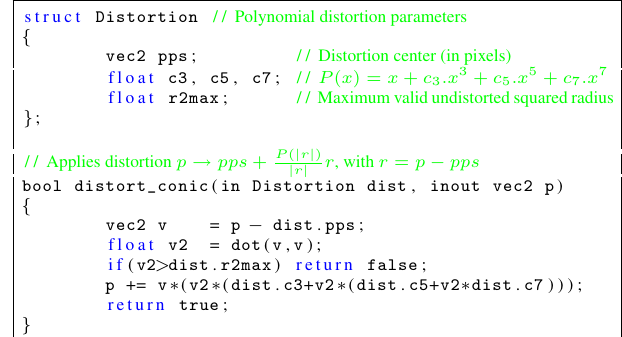
Figure 2: GPU code (GLSL) that modifies the ideal perspective 2D projection p (in pixels) to its distorted real projection for tex- ture lookup. The return value indicates whether the distortion has been successfully